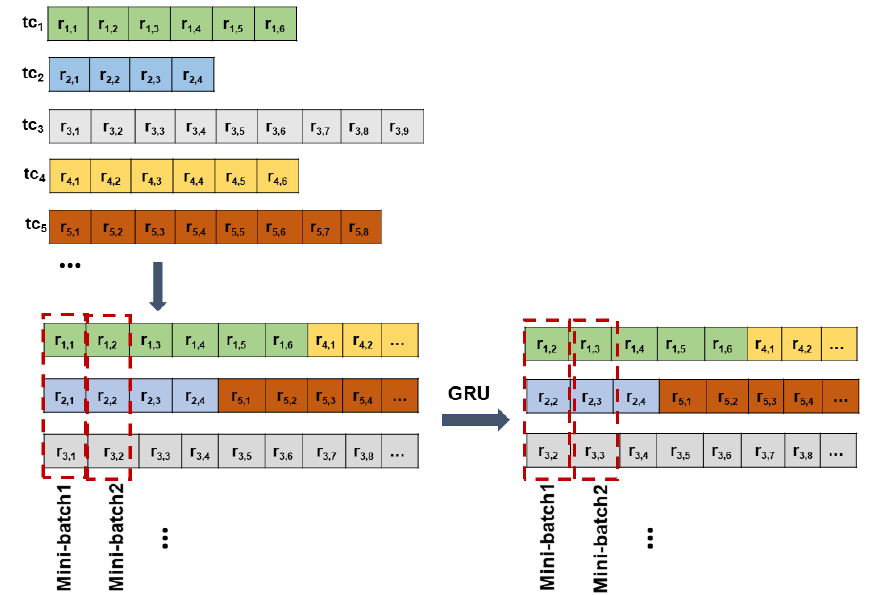
Figure 3. Customized batch method for the GRU